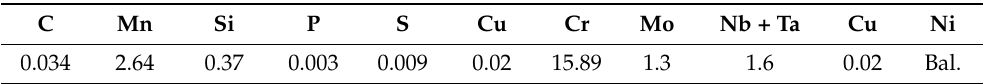
Table 1. Chemical composition of CHN327 alloy designed in this study, mass/%.